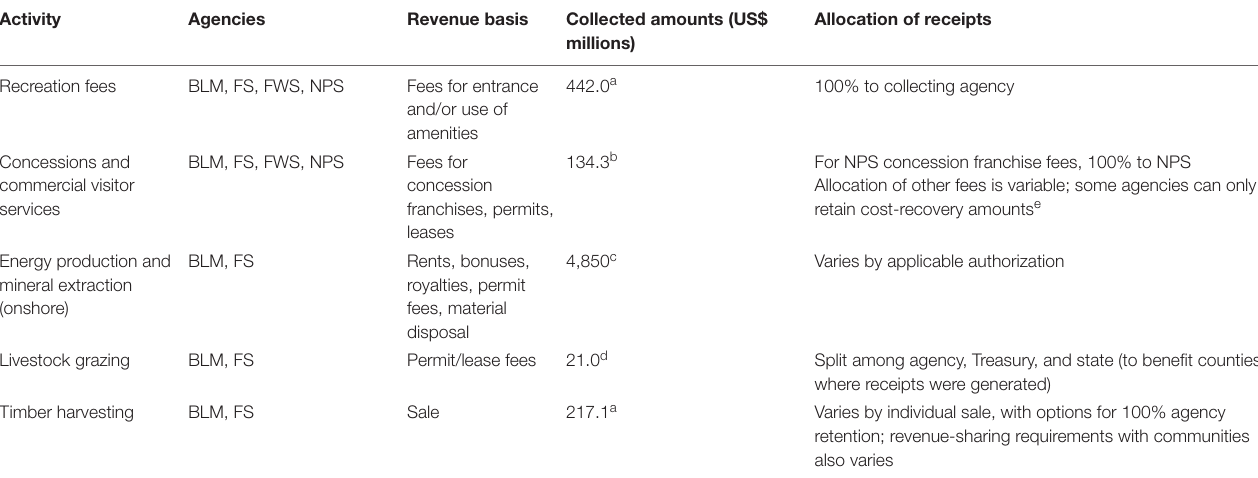
TABLE 3 | Revenue generating programs and activities of United States federal land management